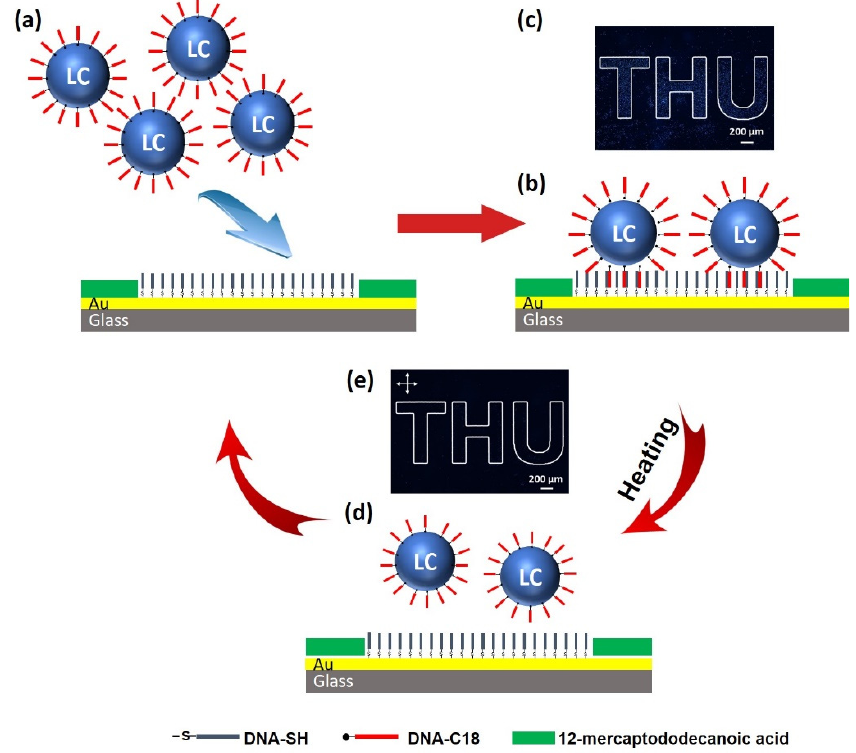
Figure 7. Schematic illustration of repeatable printing patterns with DNA ‐ modified LC droplets. ( a ) Add DNA ‐ modified LC droplets onto the surface of DNA ‐ modified gold substrate, ( b ) the formation of a specific pattern through the base pair complementation rule, ( c ) corresponding polarized image, ( d ) experimental repeatability through breaking the base pair bond at 60 °C, and ( e ) corresponding polarized image taken at room temperature.